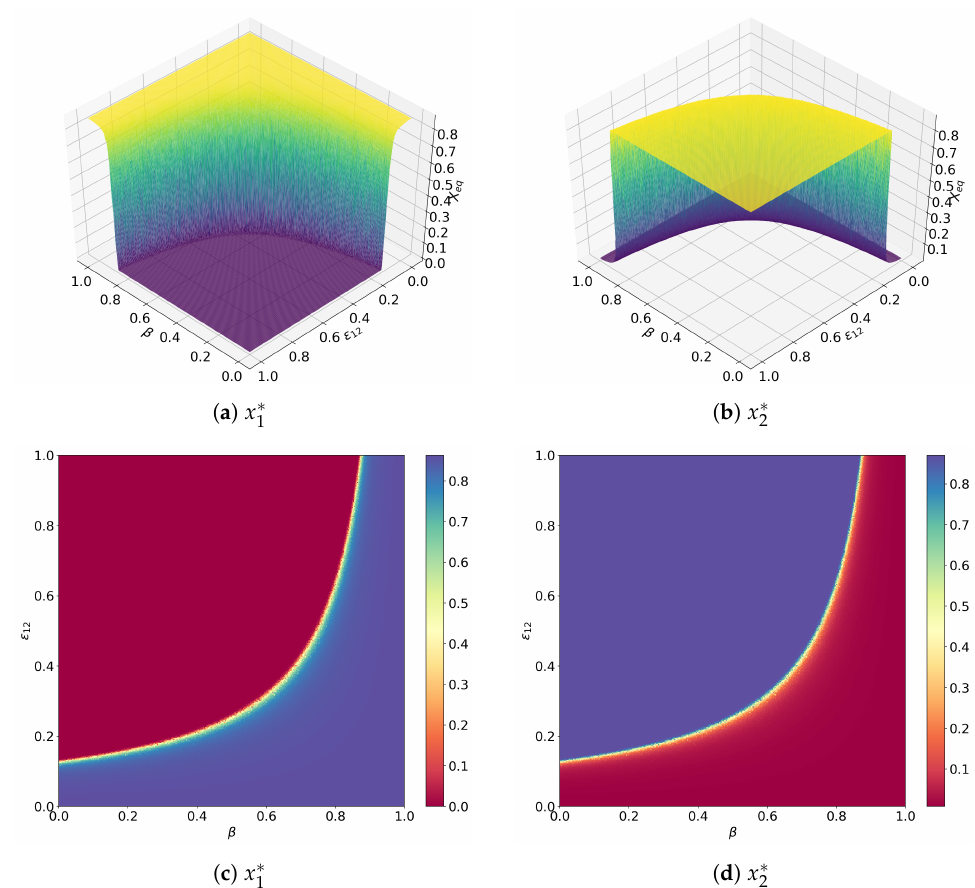
( a , c ) and x ∗ ( b , d ) as a function of ε 12 2 1